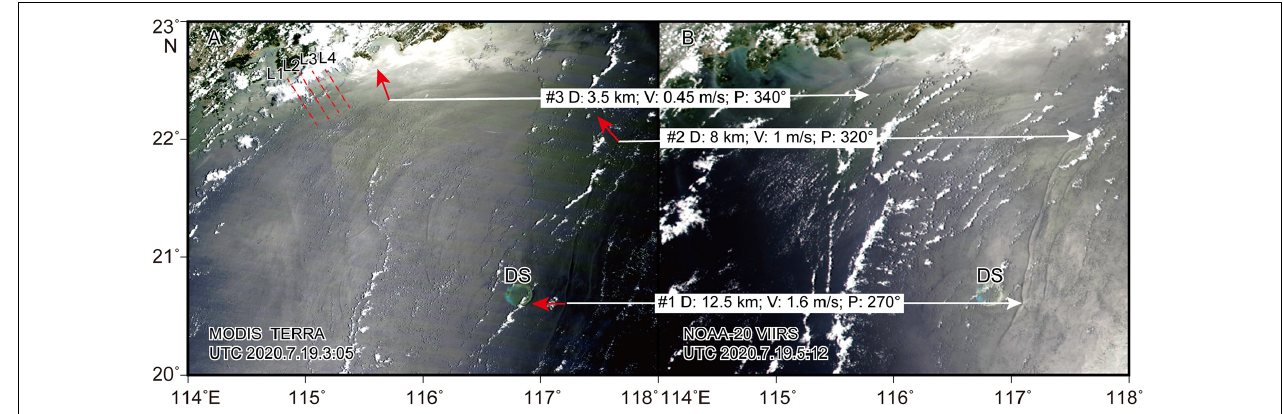
FIGURE 4 | Two satellite images of the ISWs acquired by NASA MODIS Terra (A) and 20 VIIRS satellites (B) with an approximately 2-h lag. Propagation distances, mean velocities, and directions (solid red lines with arrows) were measured between the two images with similar wave crests (white solid lines with arrows). Red dashed lines are the acoustic backscatter survey lines of L1, L2, L3, and L4. D, distance; V, mean speed; P, direction of propagation (clockwise from north); DS, Dongsha Plateau.